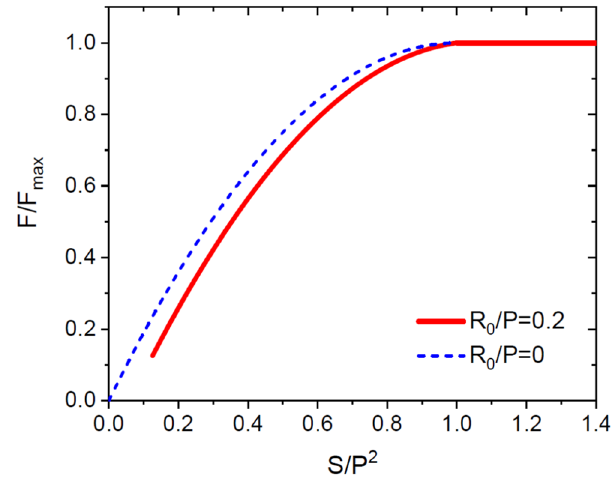
Figure 2. Normalized group III atomic current versus the normalized NW surface area x = S / P 2 obtained from Equation (5) for catalyst-free NWs at a constant radius R 0 for R 0 / P = 0.2 and R 0 / P → 0. In the latter case, the dependence is reduced to F / F max = 2 x − x 2